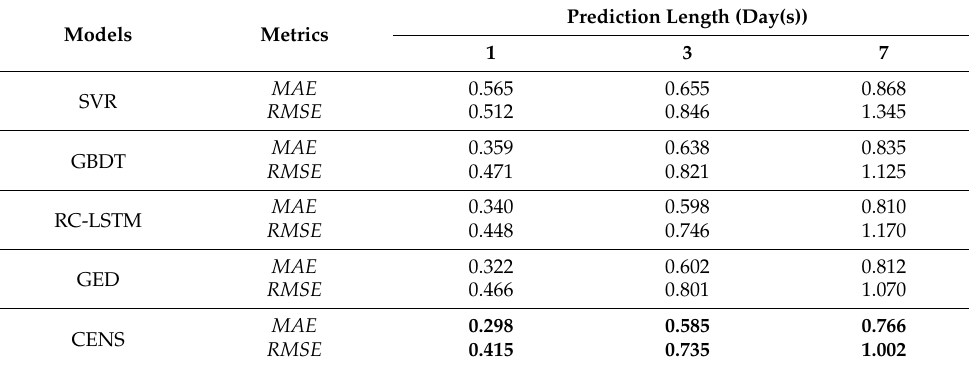
Table 1. Time series prediction results in the Bohai